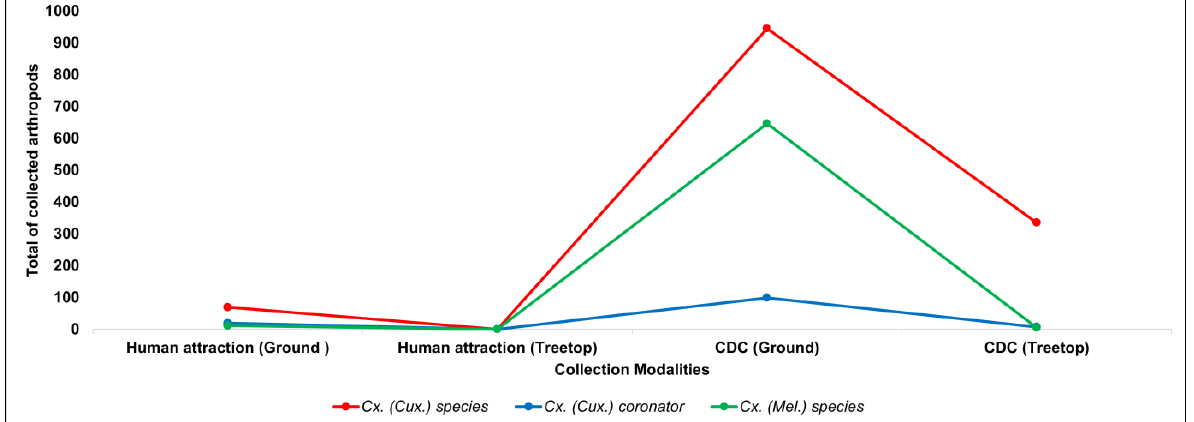
Figure 2. Distribution of the total number of Culex arthropods collected, according to the type of collection.